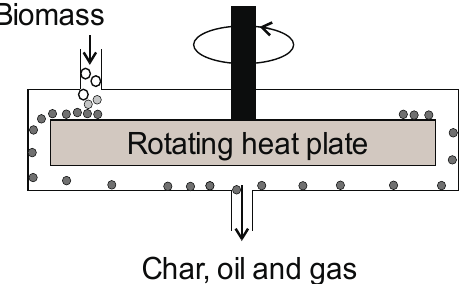
Figure 12. Ablative pyrolysis reactor.